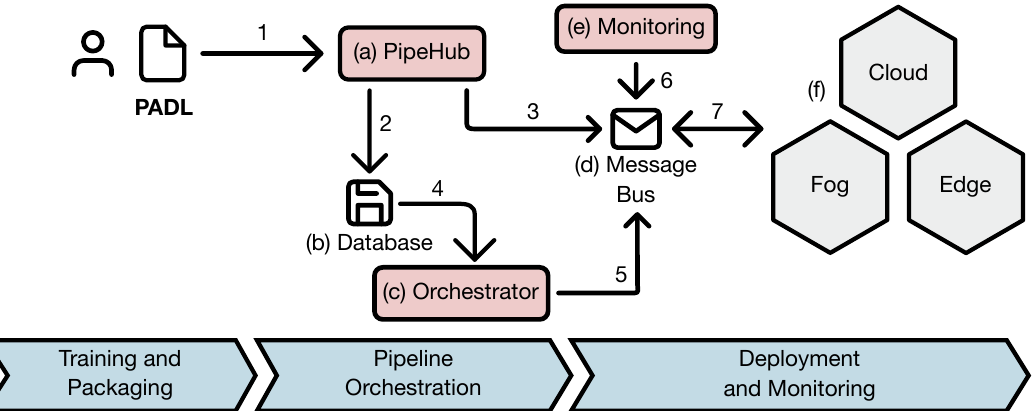
Figure 1. Reference PADL